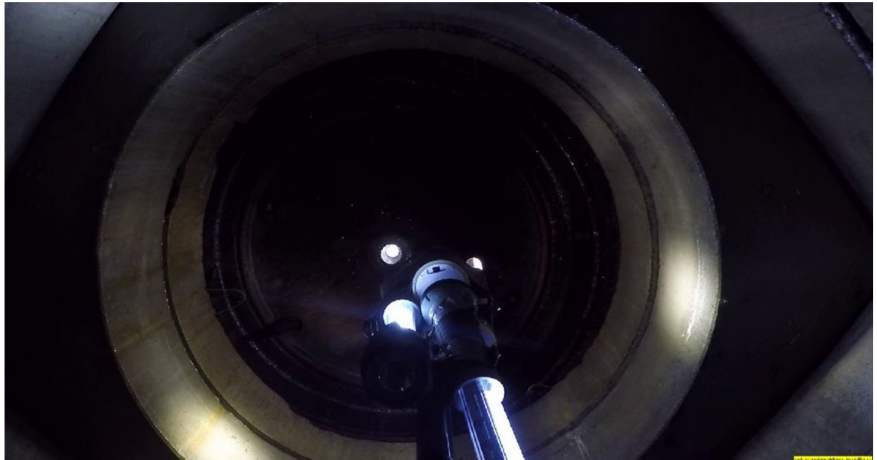
Figure 4. Image capture from Tracker showing the interior of the structure and some of the lighting prior to application of the “baseline subtract” function.